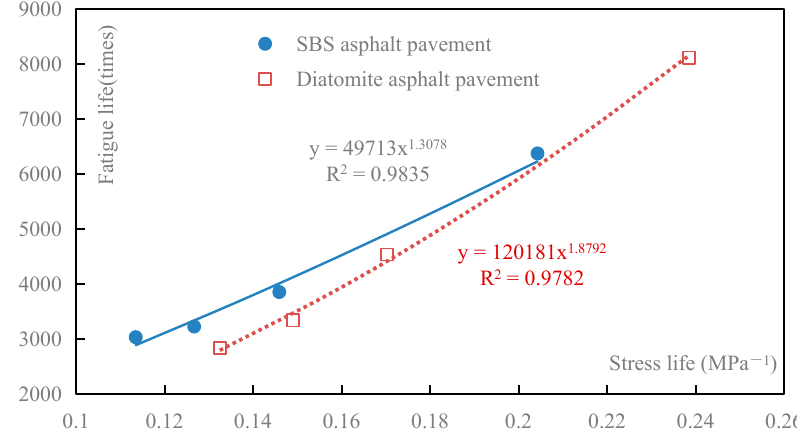
Figure 8. Fatigue test results of pavement with different asphalt mixtures.